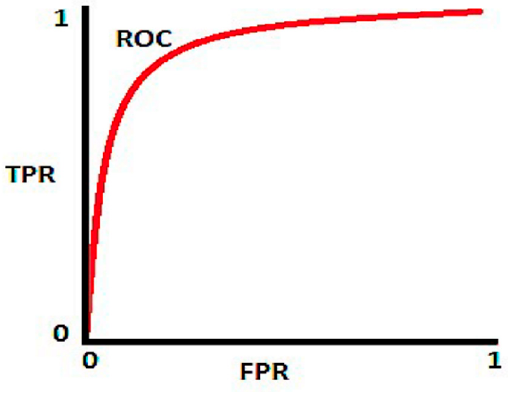
Figure 8. Illustration of area under the ROC curve.